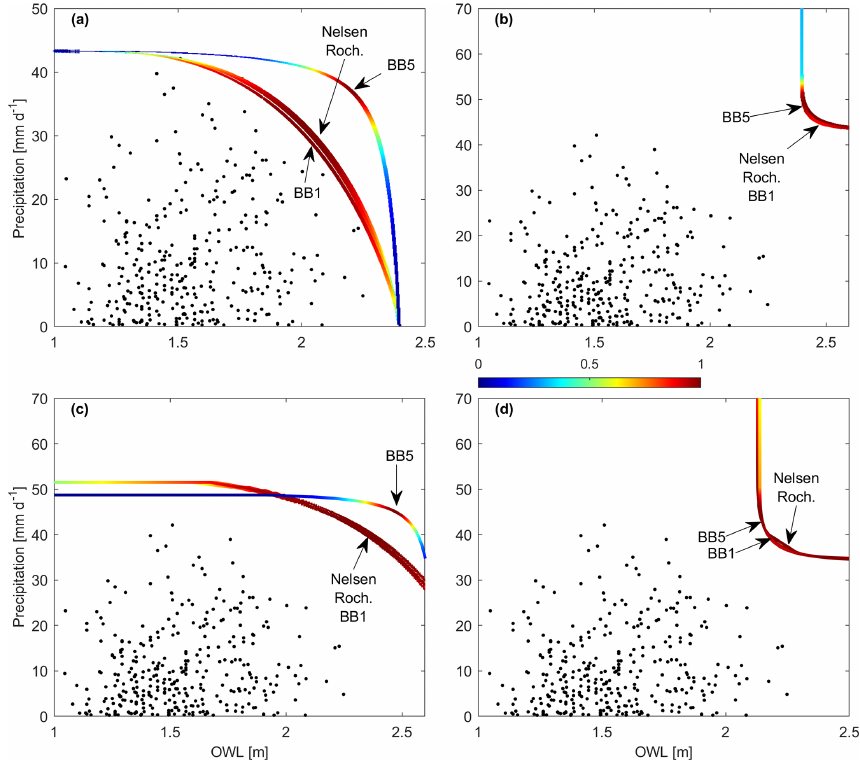
Figure 6. San Diego wet-season monthly coinciding (a) AND, (b) OR, (c) SK, and (d) K hazard scenarios with the Nelsen, Roch–Alegre (Roch), BB1, and BB5 100-year isolines. Copula labels point to the mostly likely value on their respective